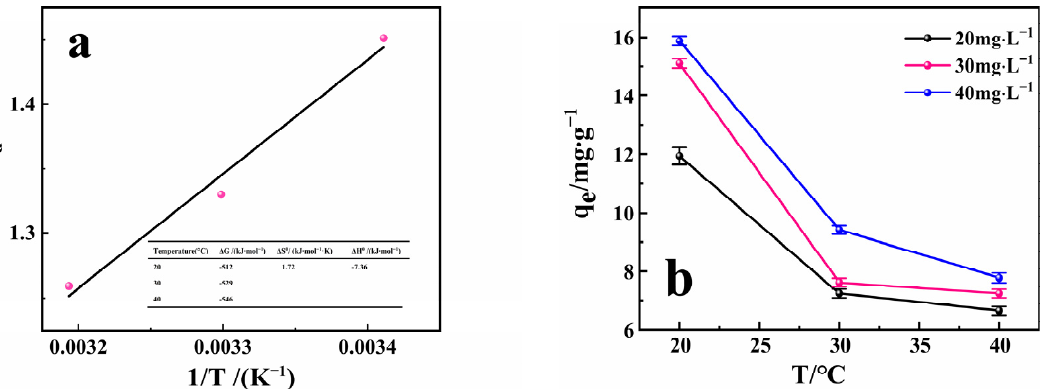
Figure 8. ( a ) Fitting of adsorption isotherms of PACMC. ( b ) Influence of Temperature for the ad- sorption of RhB on PACMC ( C 0 = 20 mg·L − 1 , Adsorbent mass: 1 g·L − 1 pH = 6.88, Reaction time: 24 h).